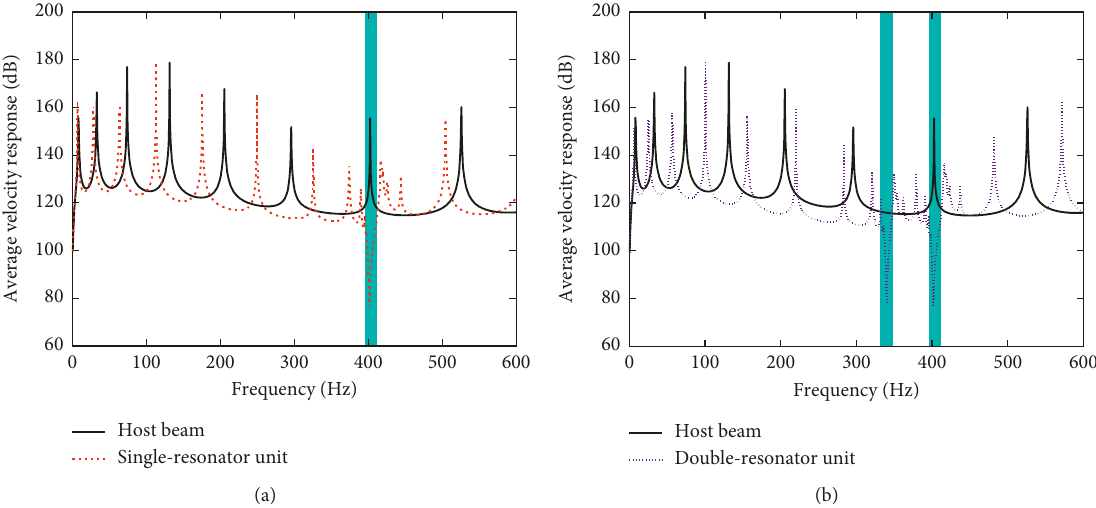
Figure 4: Average velocity response curves of the finite locally resonant beam with (a) single-resonator units contain Resonator1 (401.57Hz) and (b) double-resonator units contain Resonator1 (401.57Hz) and Resonator2 (339.89 Hz).